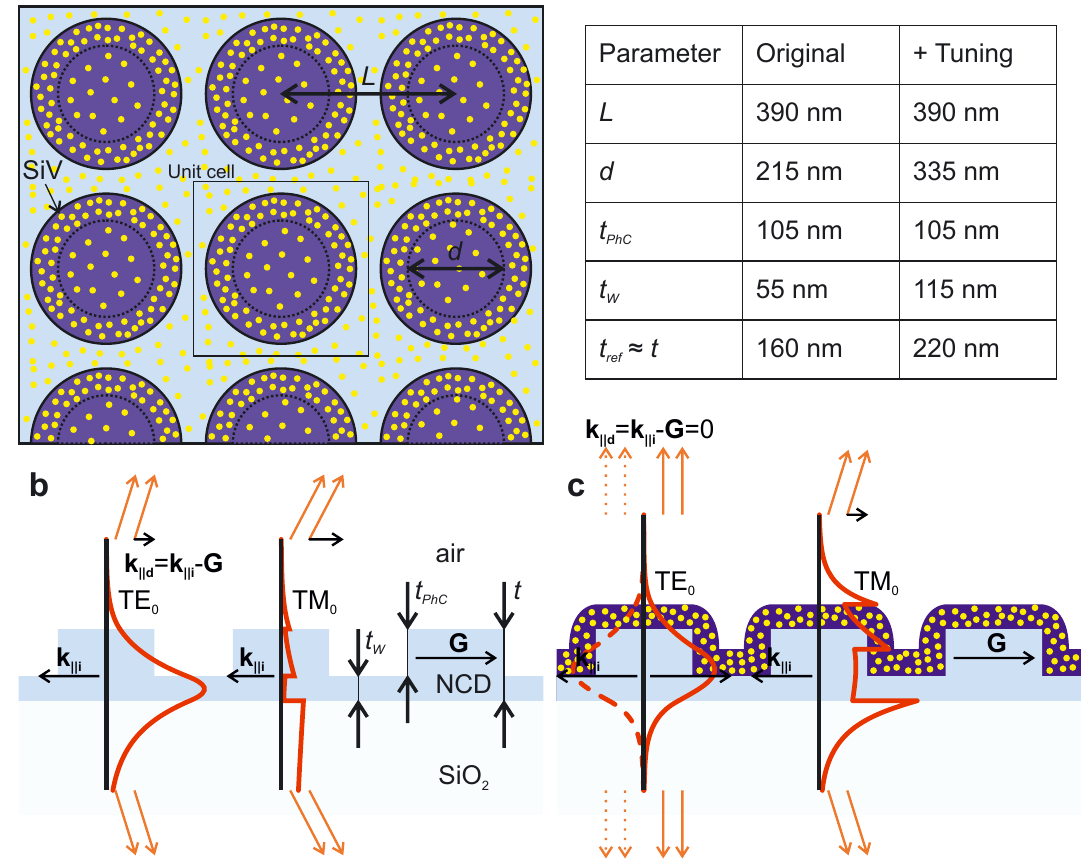
Figure 1: (a) Schematicoverview of the photonic crystal (PhC) structurecomposed of periodically-ordered columns investigated in this study. The SiV-rich (yellow dots) tuning layer is also depicted. Dotted circles denote the dimensions of the original diamond structure without the SiV-rich layer. The table summarizes the dimensions of the PhC slab: lattice constant ( L ), column diameter ( d ), thickness of PhC layer ( t PhC ), thicknessofwaveguidinglayer( t W )andtotalthickness( t ).Theestimateduncertaintyis5 –